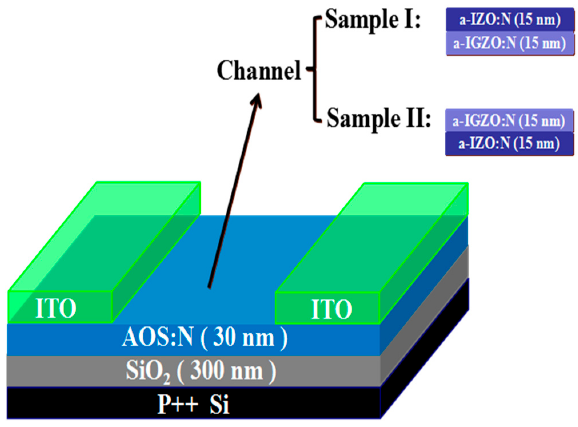
Figure 1. Schematic cross-section of the N-doped double-stacked channel layers (DSCL) thin film transistors (TFTs) (Samples I and II).